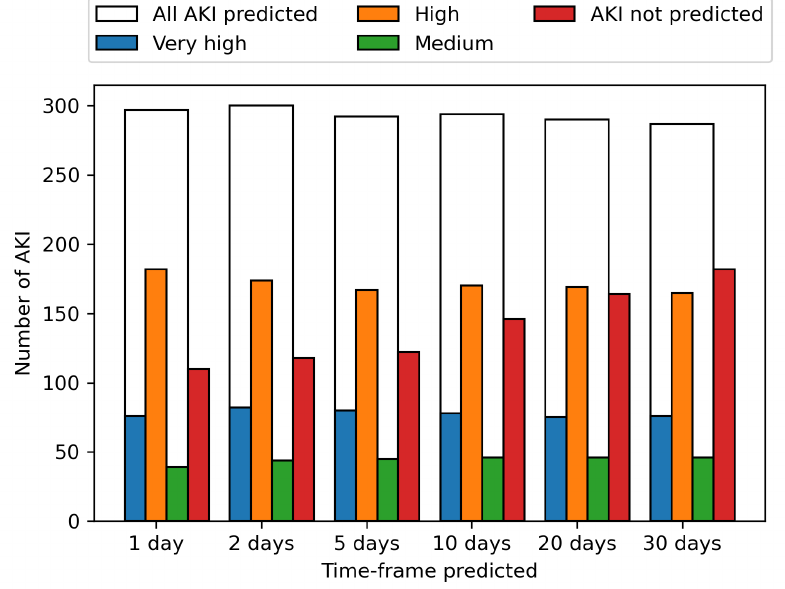
Figure 4. Bar chart showing predicted risk levels at different AKI time-frames. Predicted risk levels at different AKI time-frames during the period from 1st June to 31st August, ranging from 1 day before AKI occurrence to 30 days. The white bar shows all predicted correctly AKIs in the time-frame with the highest risk level predicting this occurrence given by the bars ‘Medium’, ‘High’ or ‘Very high.’ AKI that occurred in the time-frame but were not predicted by a ‘Medium’ or higher risk level are also shown. We see that AKI are more likely to be correctly predicted the closer to incidence with 61.2% of AKI events identified up to 30 days before onset, 63.7% 20 days before onset, 66.8% 10 days before onset, 70.4% 5 days, 71.8% 2 days and 72.8% the day before